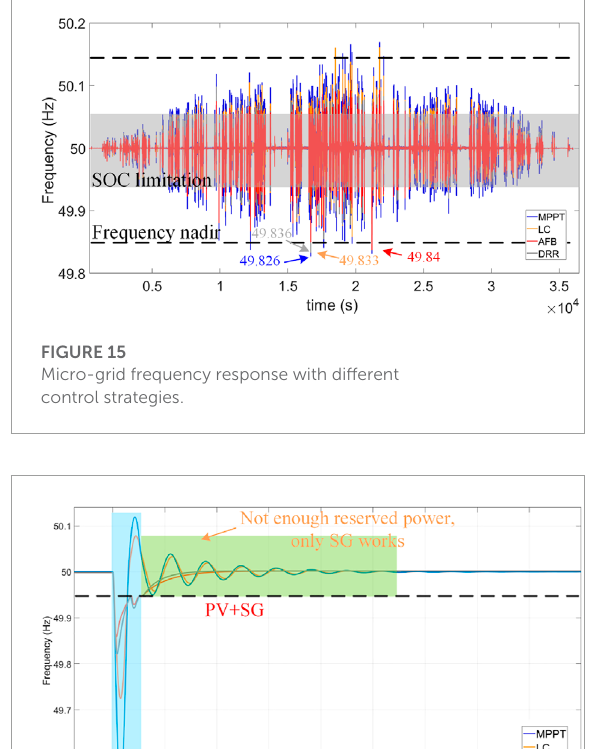
TABLE 1 Corresponding parameters of the tested system.